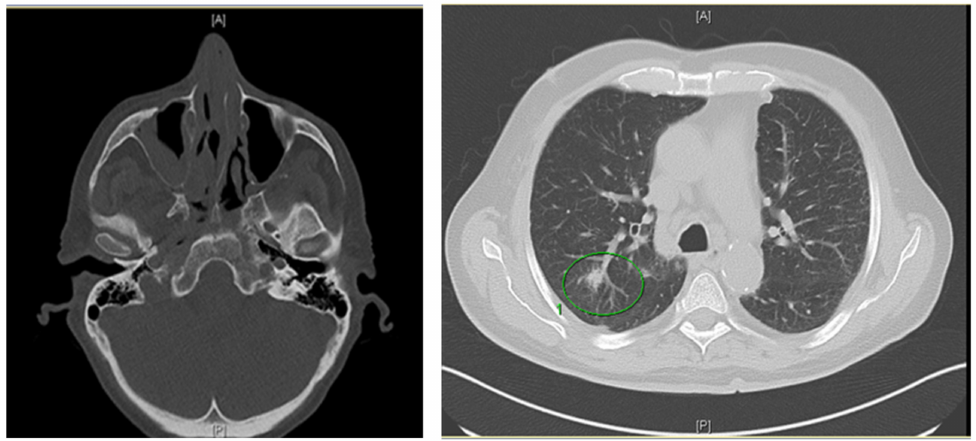
Figure 1. Radiological findings in a patient with acute myelogenous leukemia demonstrating mucosal swelling of the right sinus maxillaris and a nodular lung lesion (green circle) suggesting sinusitis and pneumonia.